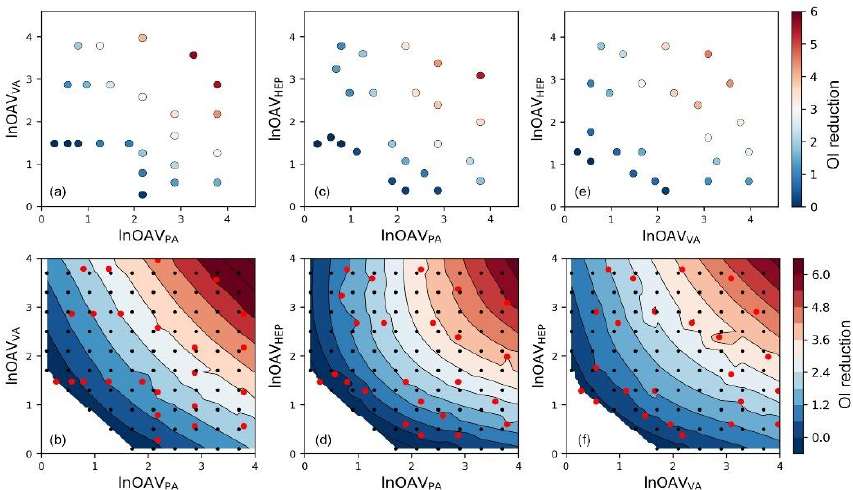
Figure 3. The scatter plot of the relationship between olfactory measured odor intensity reduction degree ( OI reduction ) and components’ ln OAV values, and corresponding contour map after adding SVR model predicted data (in the contour map, red dots: olfactory measured data; black dots: SVR predicted data) for binary mixture ( a , b ) PA+VA, ( c , d ) PA+HEP, and ( e , f ) VA+HEP.